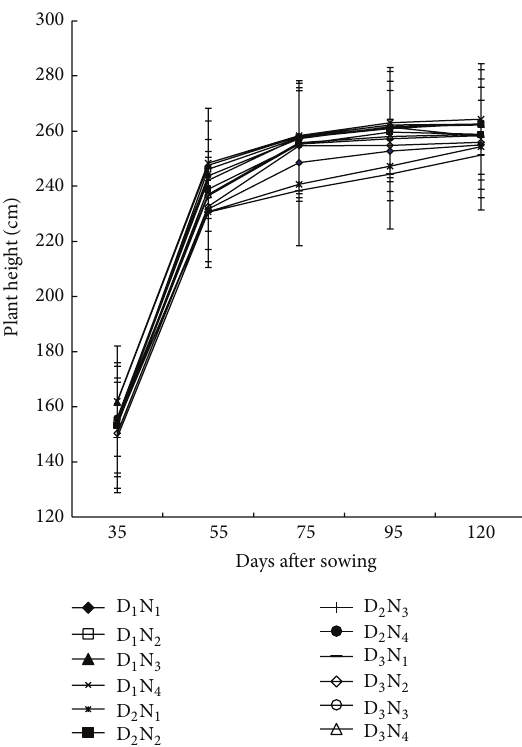
Figure 1: Plant height of maize at successive growth stages as affected by planting density and N levels (D 1 = 53,000 plant/ha, D 2 = 66,000 plant/ha, D 3 = 80,000 plant/ha, N 1 = 100 kgN/ha, N 2 = 140kg/ha, N 3 = 180 kgN/ha, N 4 = 220 kgN/ha. Bar showed ± SE